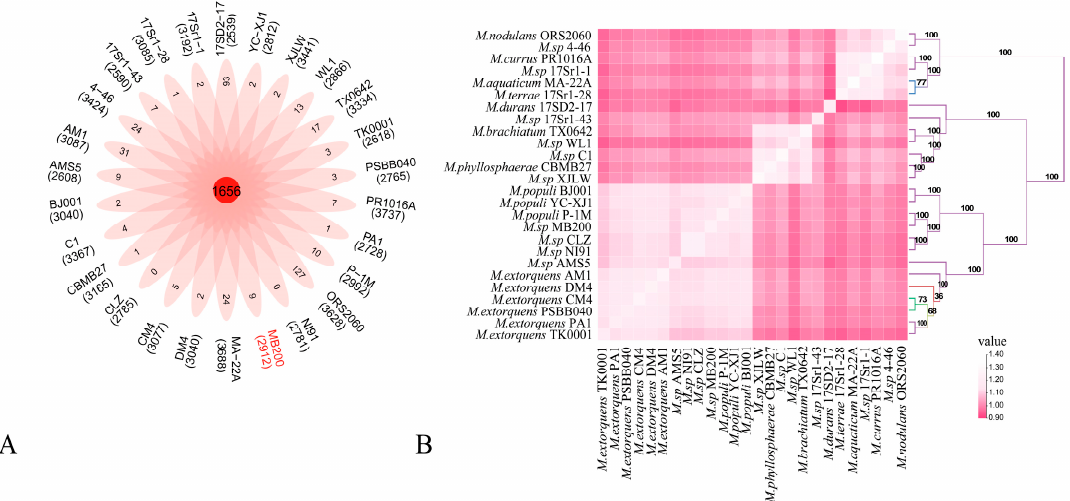
Figure 3. Comparative genomic study of 26 Methylobacterium strains with complete sequence. ( A ) Analysis of orthogroups of the 26 Methylobacterium strains. The 1656 core orthogroups shared by all strains are indicated in the center (red), and the unique orthogroups are indicated on each petal. ( B ) Correlation analysis of the orthogroups among 26 strains. The more the occurrence of same orthogroups, the higher the p -value. Phylogenetic tree on the right shows the evolutionary relationship among the 26 Methylobacterium